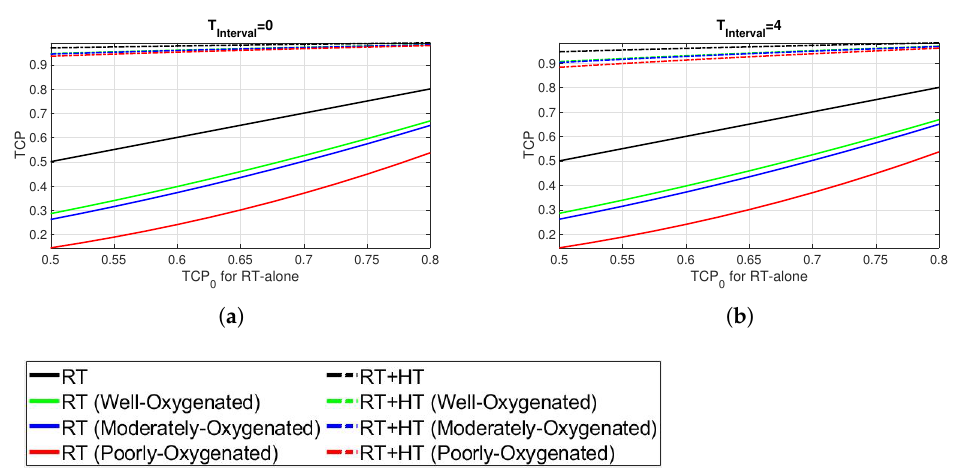
Figure 7. TCP at time intervals ( a ) 0 h and ( b ) 4